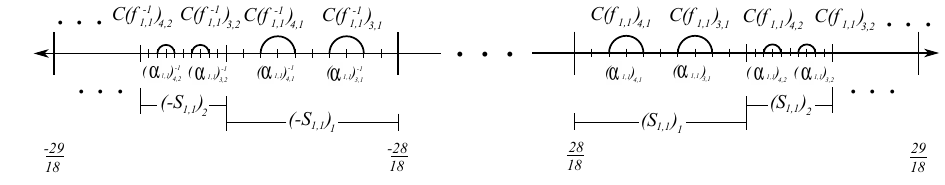
Figure 13: The closed intervals S 1,1 and − S 1,1 .